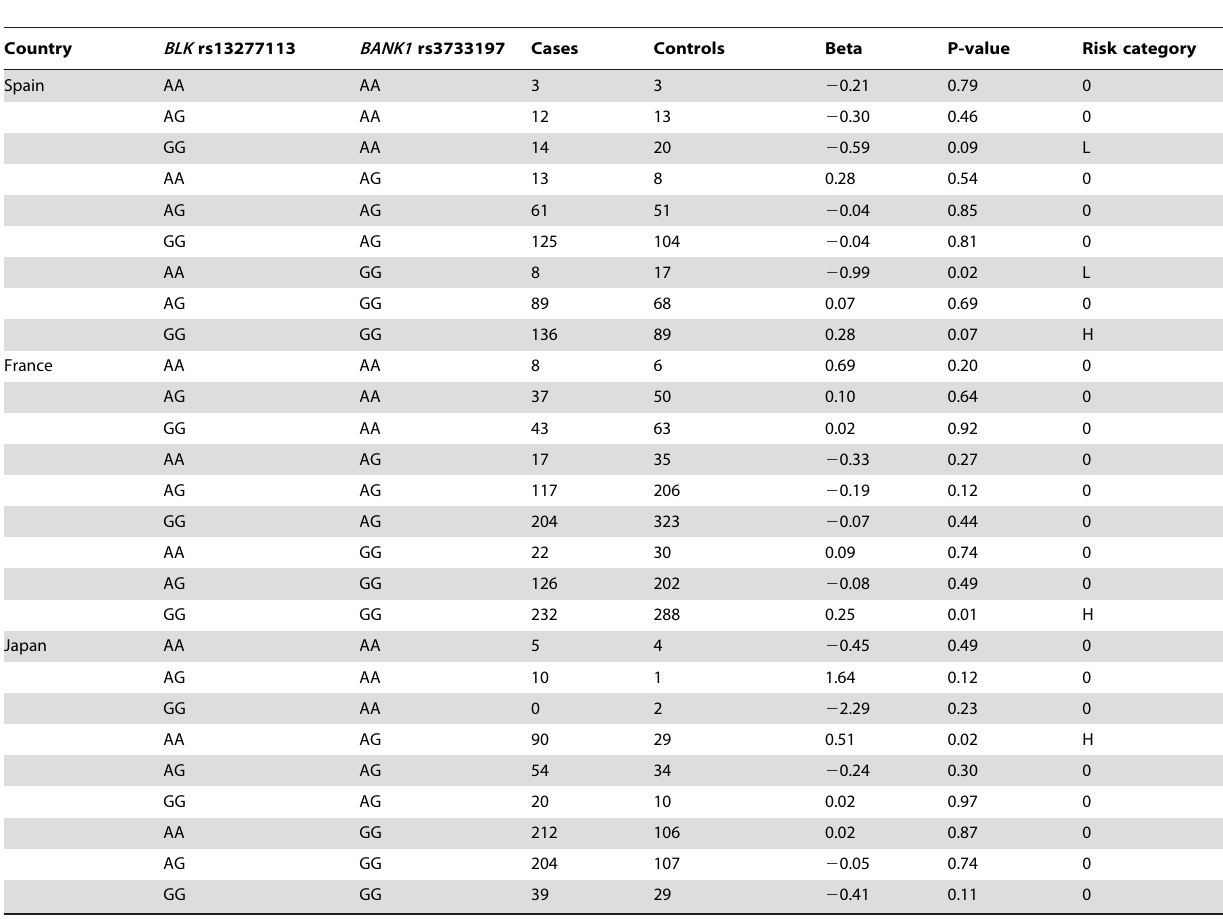
Table 3. Distribution of BLK-rs13277113 and BANK1-rs3733197 multilocus genotypes in cases and control populations from Spain, France and